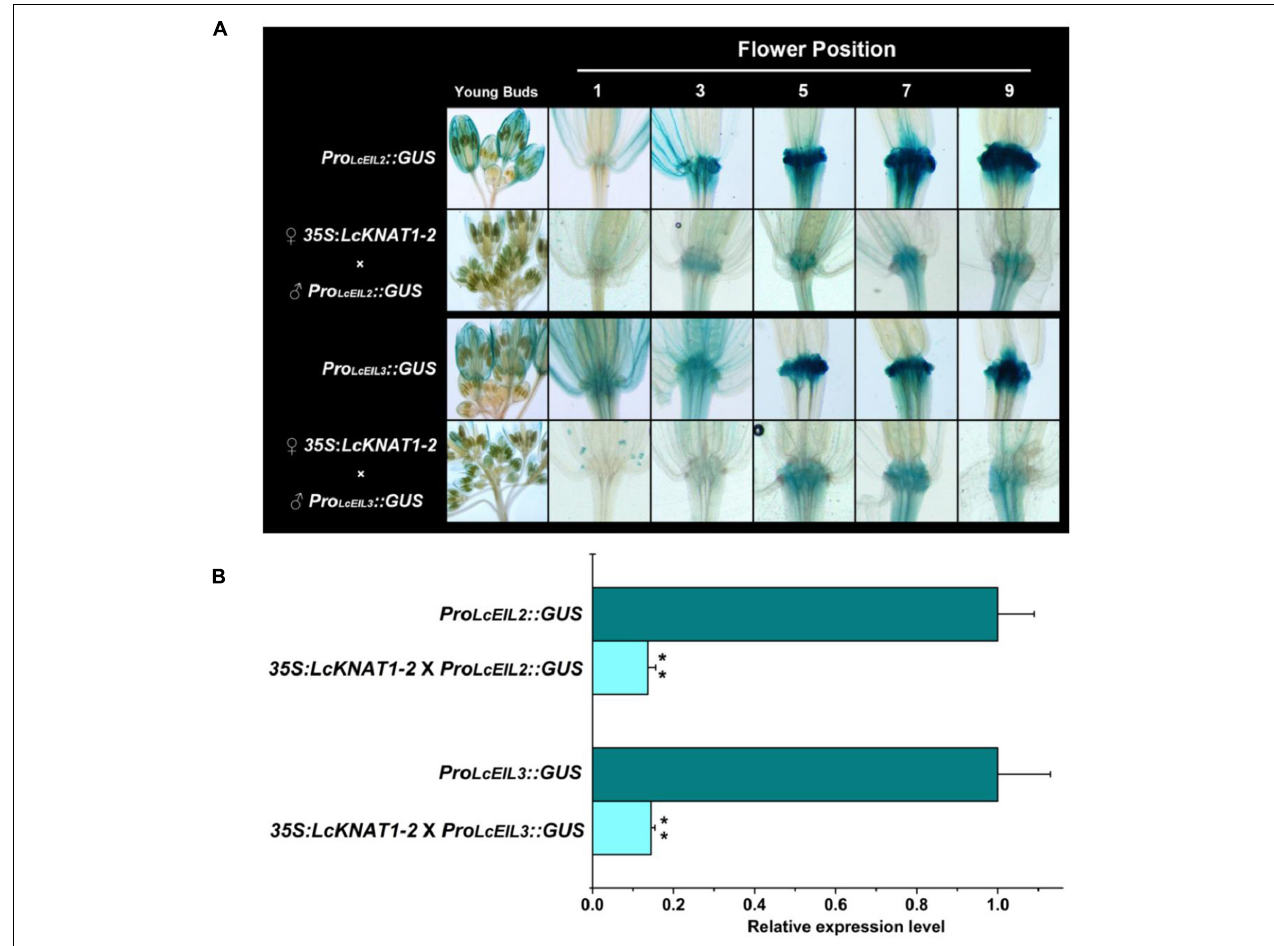
FIGURE 6 | GUS expression driven by the promoter of LcEIL2 or LcEIL3 is repressed by LcKNAT1.